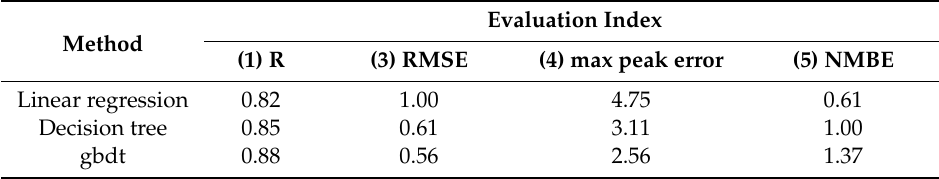
Table 13. Evaluation index for each model (April 2016).